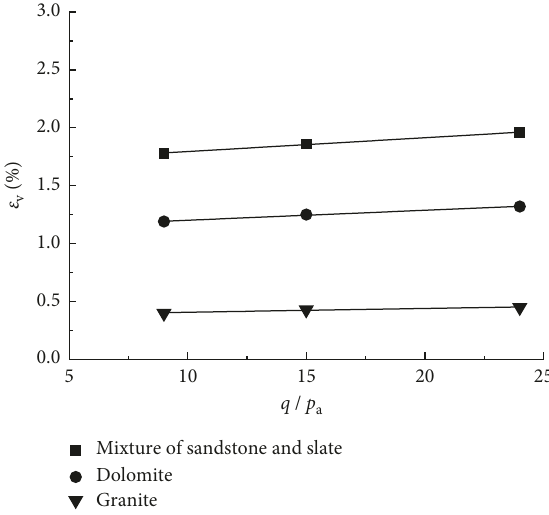
Figure 14: q / p a versus ε v curve (different sample dry density conditions).